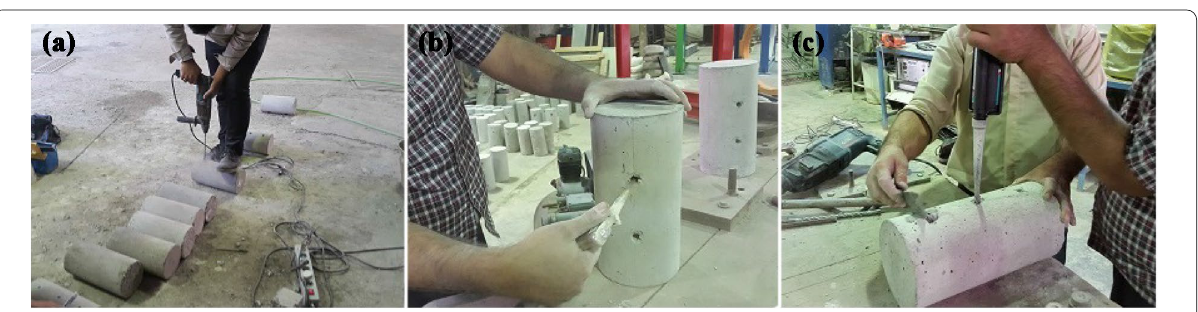
Fig. 3 Rebar planting operation: a hole drilling; b hole cleaning; c rebar